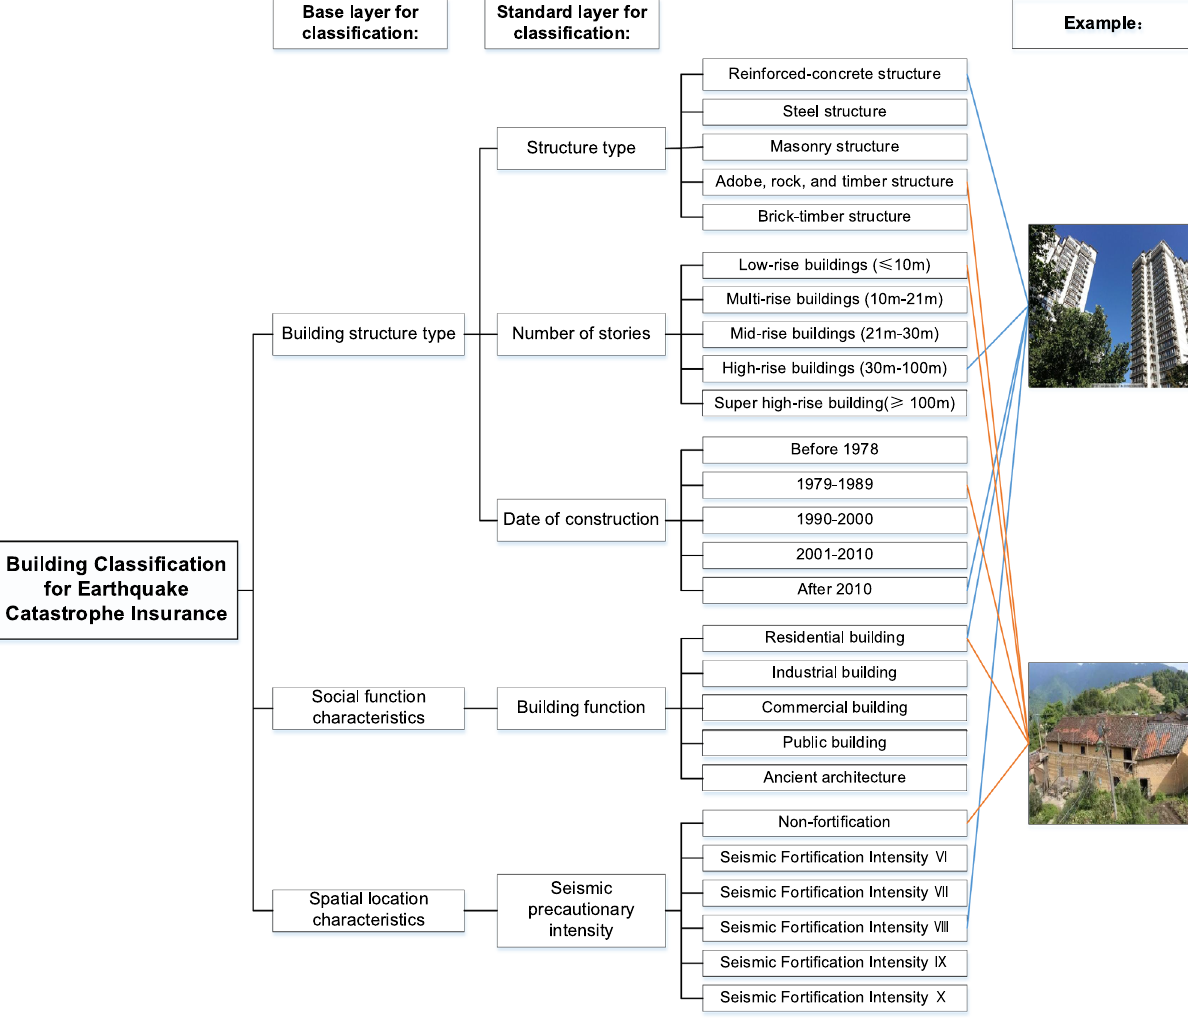
Fig. 2 Building classification for earthquake catastrophe insurance in